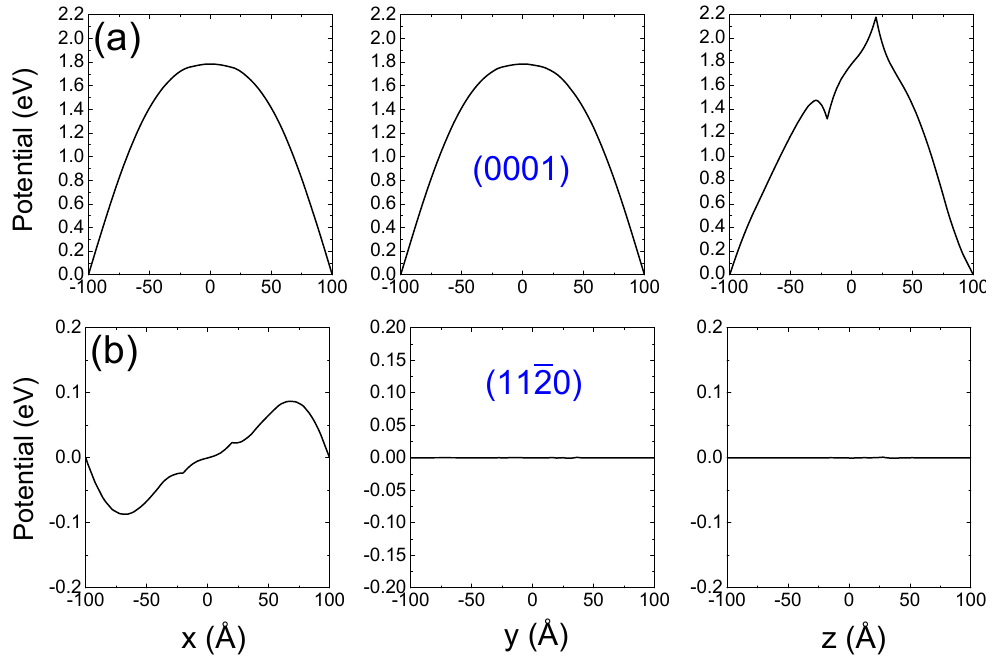
Figure 2. Calculated potential along x -, y -, and z -axes for ( a ) (0001)- and ( b ) (11¯20)-oriented GaN/AlN QD structures grown on GaN substrate. The length d of cubic QD is set to be 40